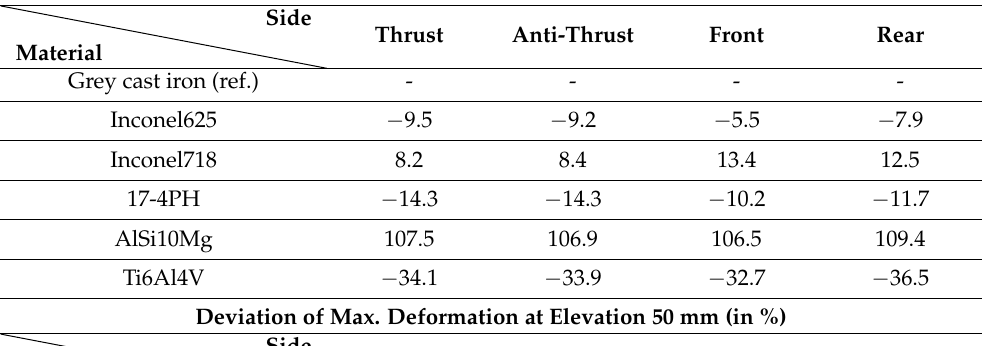
Side Thrust Anti-Thrust